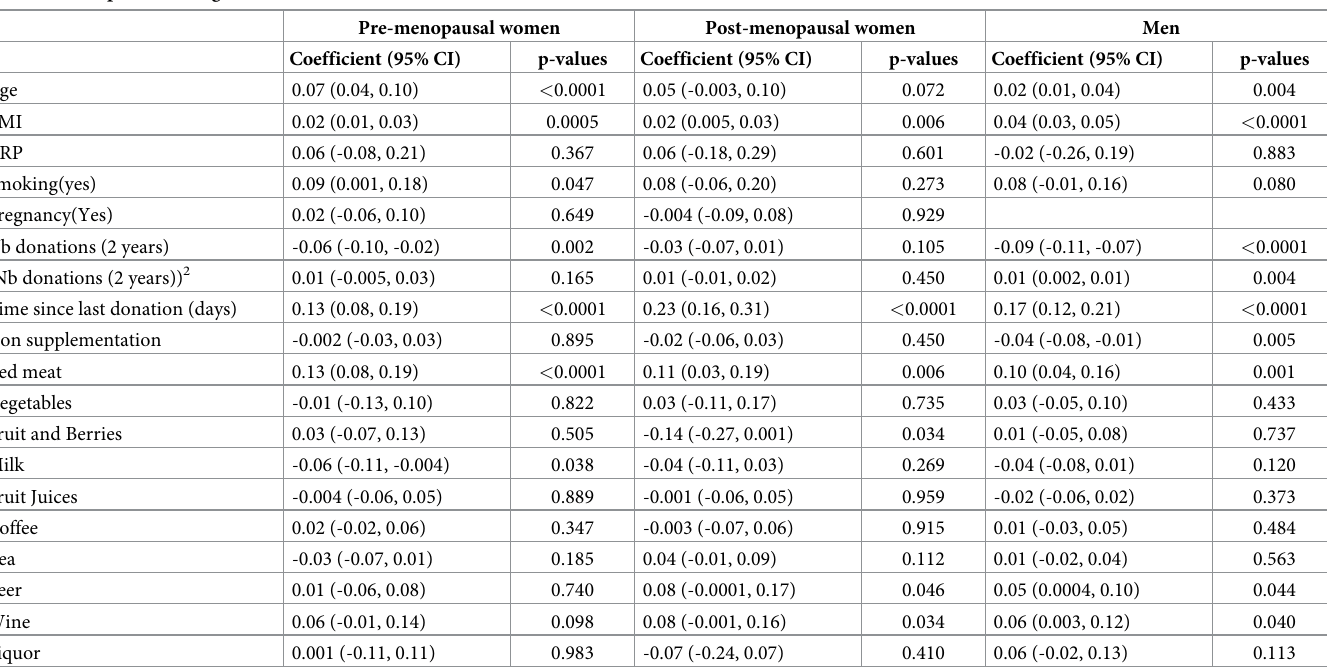
Table 3. Multiple robust regression results for ferritin levels.